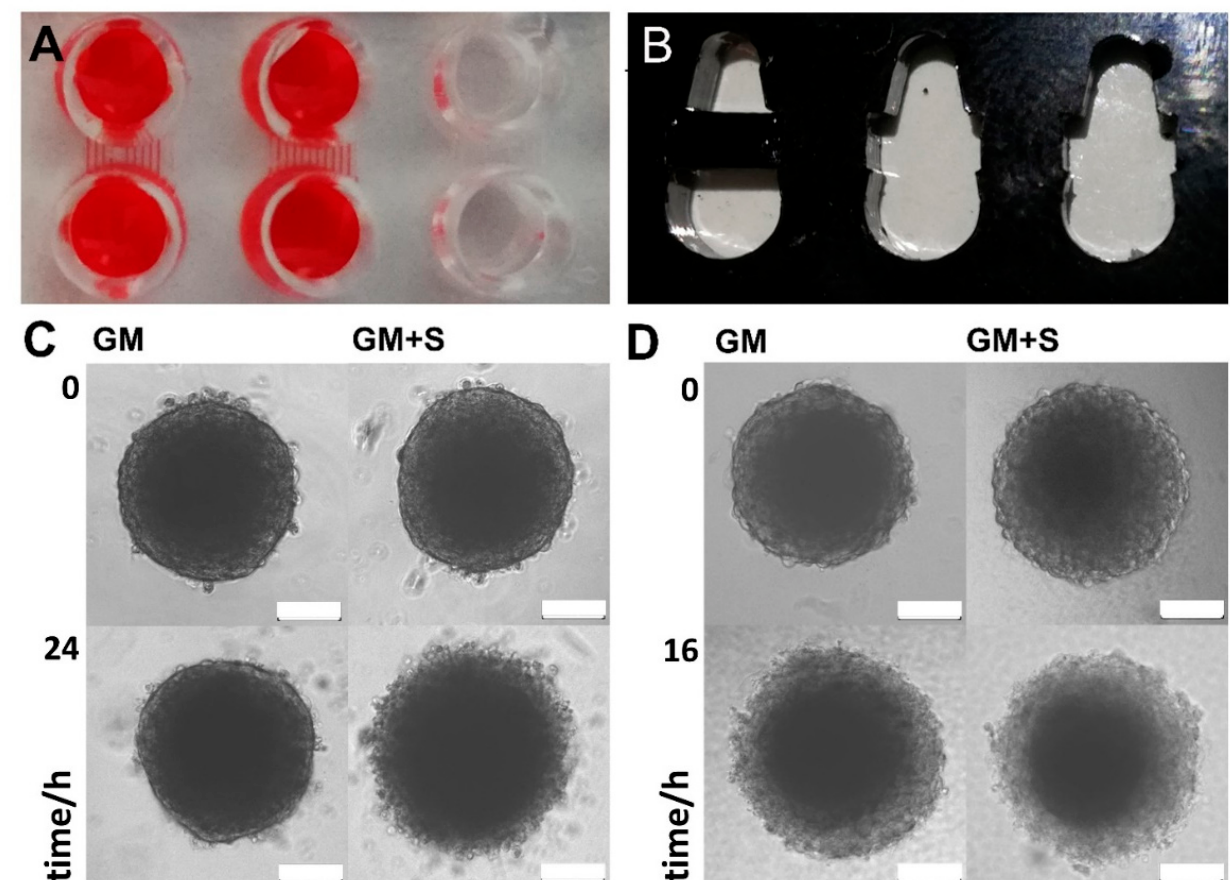
Figure 4. Twin-microwell 3D-cell aggregate analysis: ( A ): a photograph of a PDMS staining chip (top view) along with the connecting microchannels; in order to enhance the contrast and view the microfluidic channels, red solution was added to two chambers. The diameter of the wells is 3 mm; ( B ): a photograph of a PMMA staining chip (top view). The diameter of the larger (bottom) well is 3 mm; ( C , D ): microscopic images of spheroids cultured and treated in T µ W-PDMS ( C ) and T µ W-PMMA ( D ). Spheroids made from human osteoblasts, hFOB1.19 were cultivated in growth medium (GM), or in growth media containing 10 µ M staurosporine (GM + S), a cell-permeable, ATP-competitive inhibitor of protein kinases that leads to the induction of cell death; the scale bars indicate 100 µm.